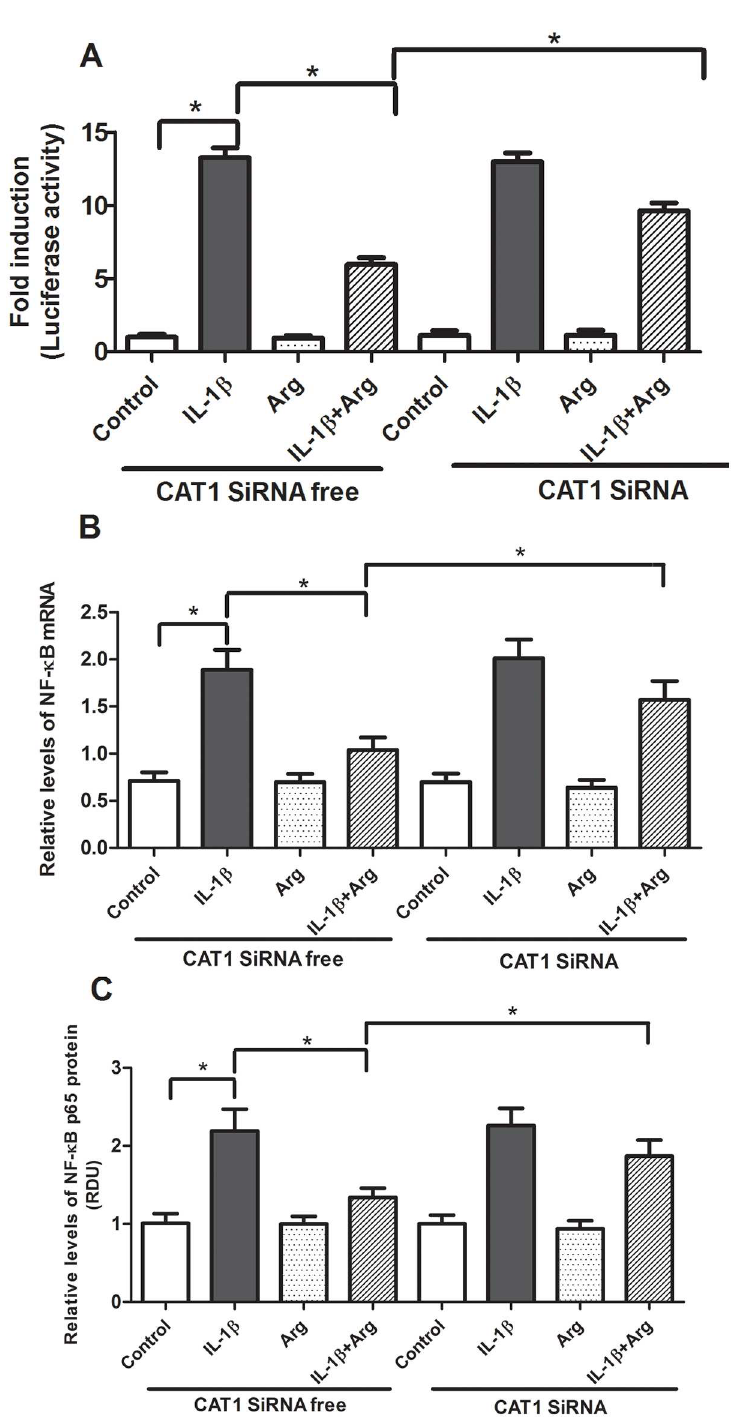
Fig 4. Effects of systemy + CAT1 siRNA and L-Arg’s ability on NF- κ Bpromoter activity and NF- κ B expression. Caco-2 transfected with system y + CAT1 siRNA for 24 hour prior to the transfectionof pNF- κ B Luc vector for 18 hours were treated with IL-1 β (4ng/ml) for 4 hours after pretreatment of 4 hours of L-Arg (5 mM) (Fresh medium with L-Arg was appliedafter removing medium for pre-treatment). Cells were collected for luciferase activity and isolations of protein and total RNA as describedin Methods . A: NF- κ B luciferase activity. Data are expressedas fold-inductionof normalized luciferase activity. B: NF- κ B mRNA levels were determined by qRT-PCR, then normalized to β -actin. C: NF- κ B p65 protein levels were measuredby Western blot analysisand normalizedto β -actin. Data are means ± SE. * P < 0.05(n = 6 /group).